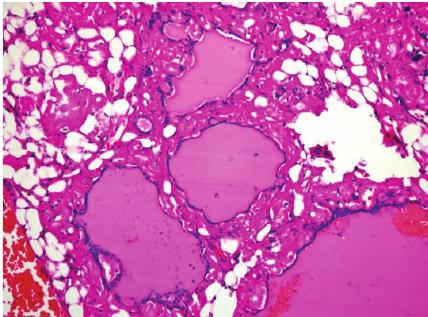
Figure 1: Diffuse eosinophilic amorphous material interfollicular sites (hematoxylin and eosin, 400x).